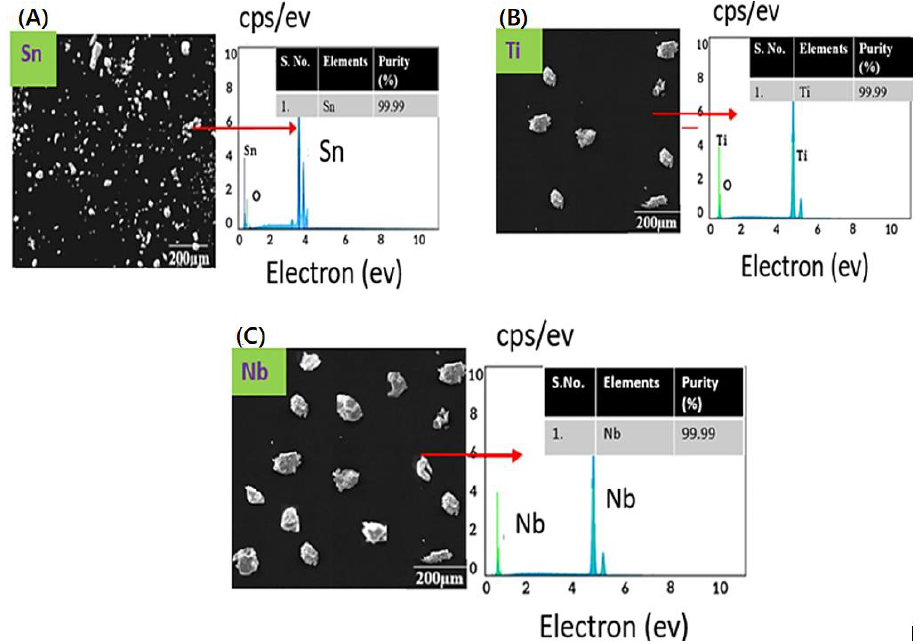
Figure 2. SEM micrographs and EDS spectra of the samples, ( A ) SEM image and EDS spectra of tin, ( B ) SEM image and EDS spectra of titanium, ( C ) SEM image and EDS spectra of niobium.